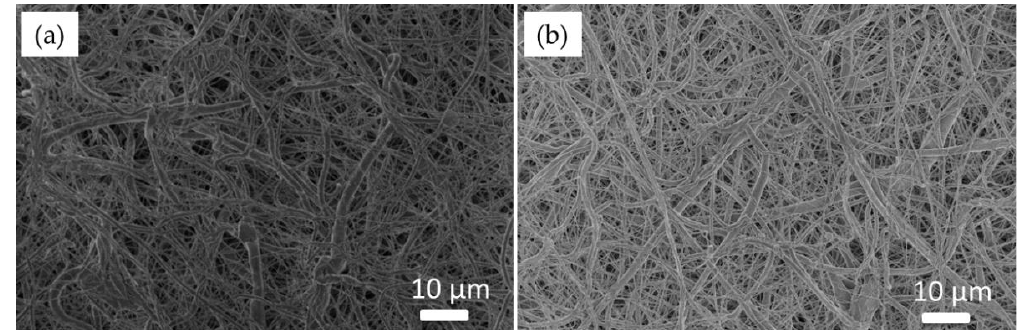
Figure 2. SEM micrographs at low voltage showing an overview at low magnification of ( a ) the bare sample vs. ( b ) Ag-coated one.